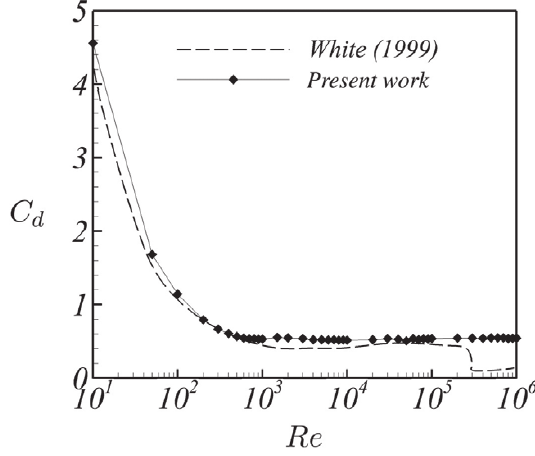
Figure 20 - Drag coefficient as a function of the Reynolds number: Re = 10 up to Re = 10 6 ; present work and White (1999).